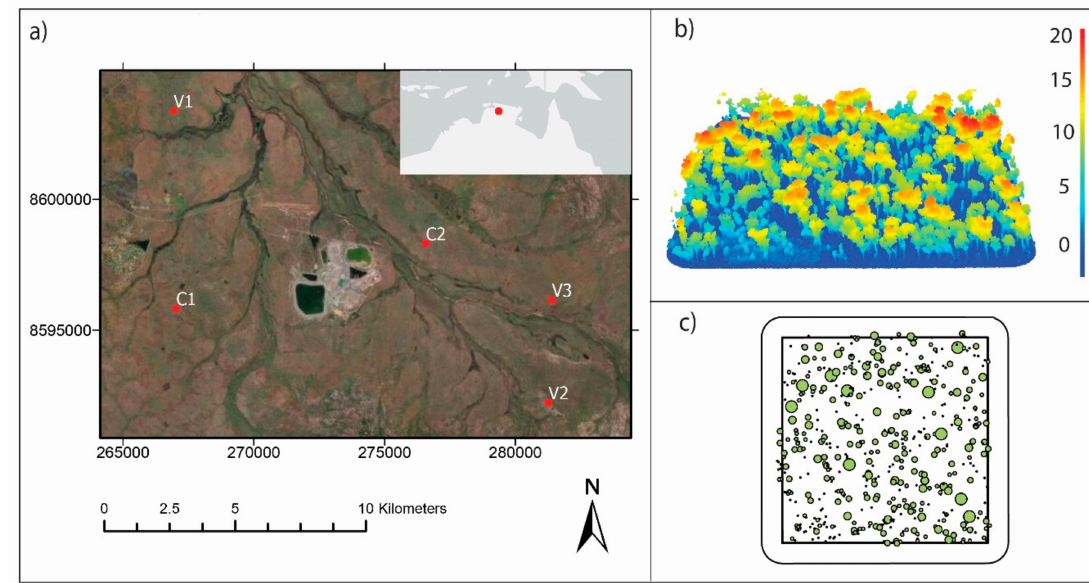
Figure 1. Summary of the sites and the primary datasets used in this study: ( a ) Location of the study site, showing calibration plots C1 and C2, and validation plots V1, V2 and V3. Coordinate system is GDA 1994 MGA Zone 53; ( b ) Example of drone derived LiDAR point cloud, colored according to height above ground level (m); ( c ) Example of field surveyed DBH, with point scaled according to DBH. The inner polygon shows the one-hectare plot and the outer polygon shows the 10m buffer used in analysis. Data shown in ( b , c ) refer to plot C1, although these data were collected at all five